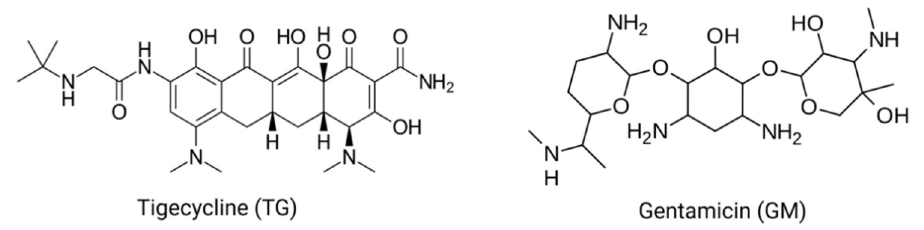
Figure 1. The chemical structure of tigecycline and gentamicin.